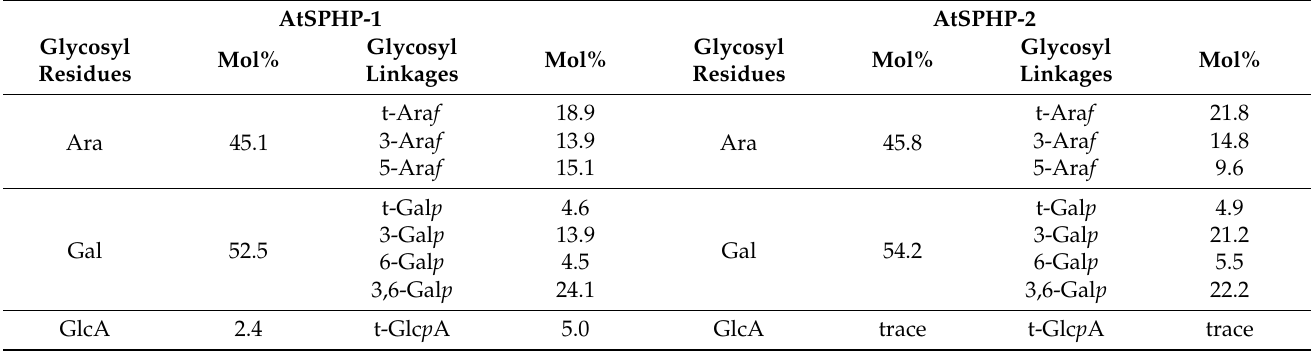
Table 1. Glycosyl composition and glycosyl linkages of AtSPHP-1 and -2. All values are mol